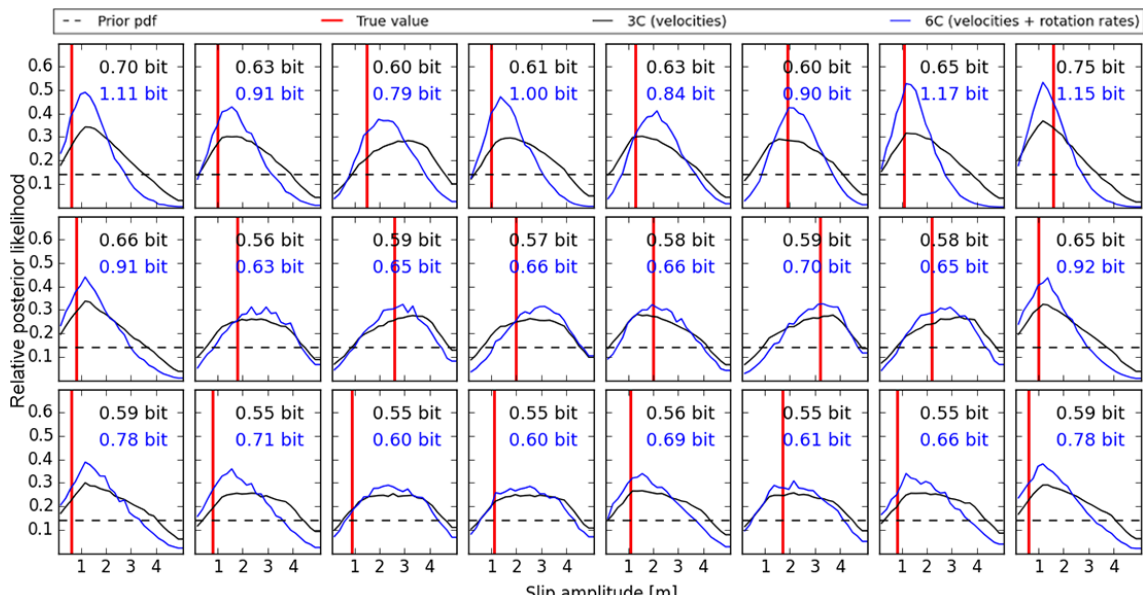
Figure 6. Inversion results for slip amplitudes for a dip-slip fault. Each panel represents a subfault with the same arrangement as in Fig. 2. For each subfault, the homogeneous prior pdf is drawn as a black dashed line, the true value for the slip amplitudes as a red vertical line, and the information gain is noted in the respective color of the inversion (3C in black and 6C in blue). The posterior pdf’s for the 3C and 6C inversions are drawn as black and blue lines, respectively. The increase in information gain is higher compared to Fig. 4 for all subfaults but is still decreasing with depth.